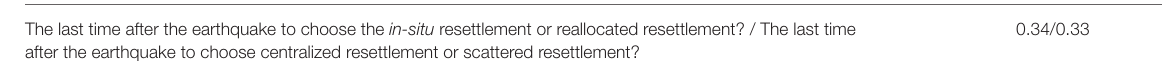
TABLE 4 | Previous recovery experiences items and sources. Items